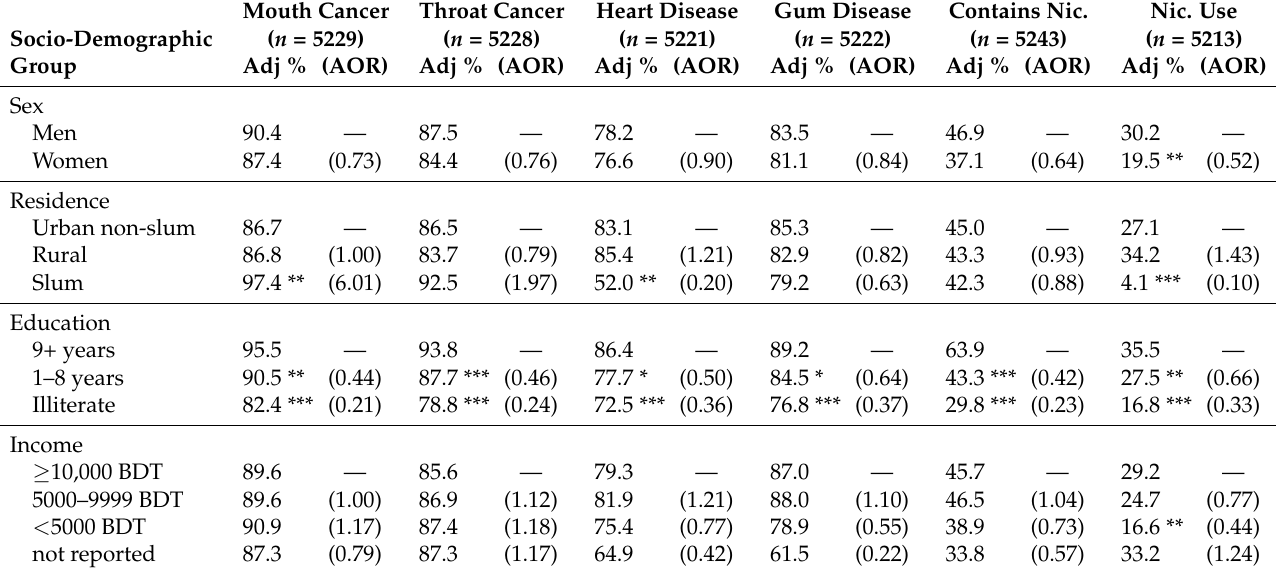
Table 4. Relationship between socio-demographic proxies of vulnerability and knowledge of harms caused by smokeless tobacco estimated using logistic regression † . Mouth Cancer Throat Cancer Heart Disease Gum Disease Contains Nic. Nic.